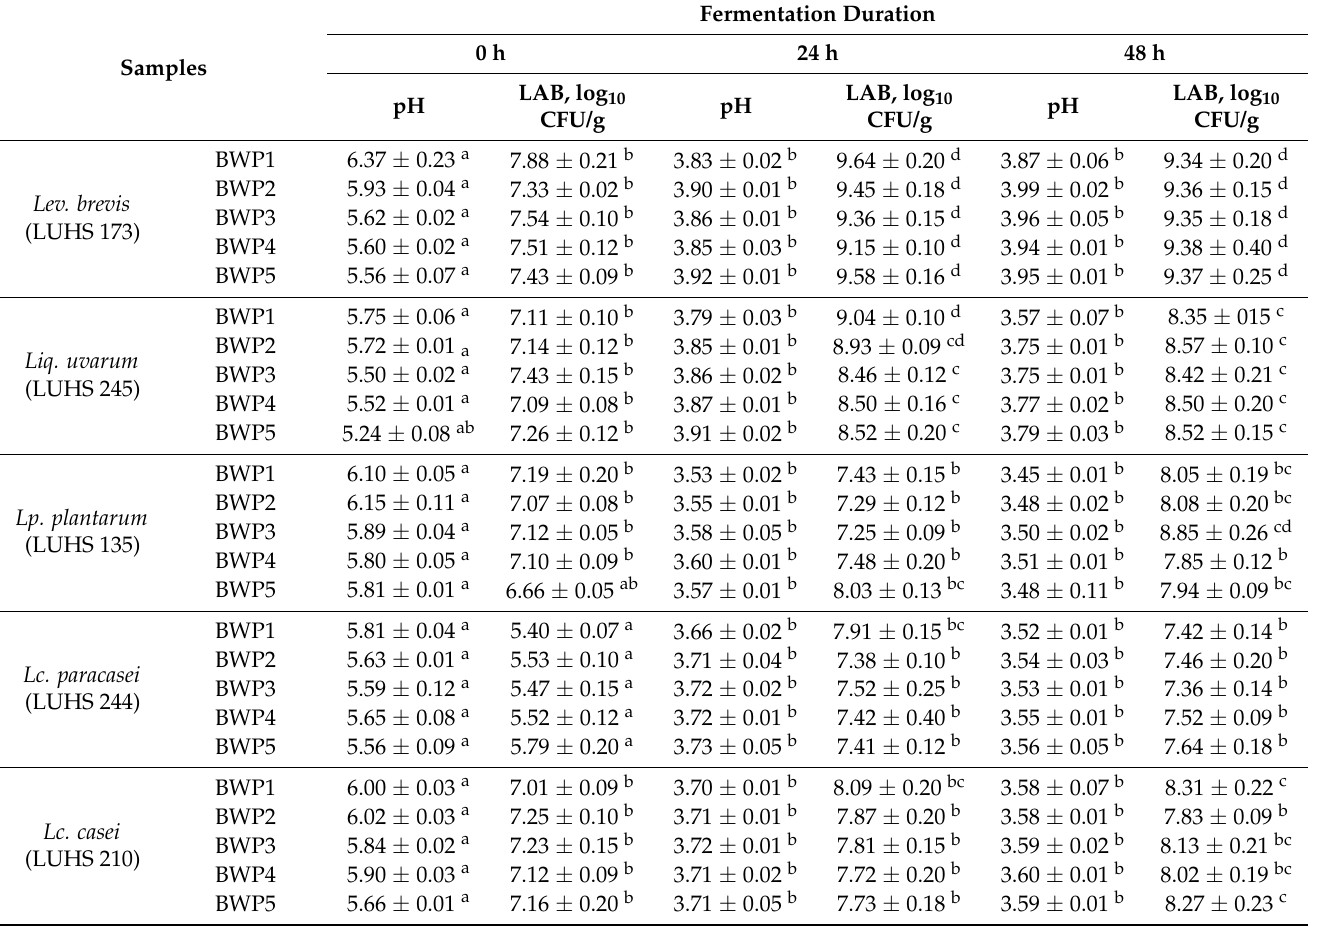
Table 2. Changes in pH and lactic acid bacteria (LAB) counts during 48 h fermentation of barley wholemeal (BWP) samples